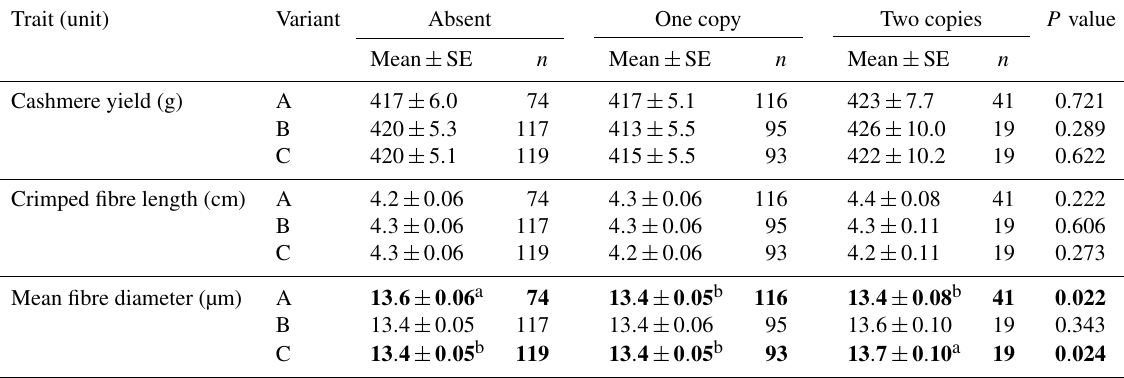
∗ Estimated marginal means and standard errors (SEs) of those means derived from general linear mixed-effects models. “Gender” and “sire” were included in the models as a fixed factor and a random factor, respectively. Means within rows that do not share a superscript letter ( a or b ) are significantly ( P< 0 . 05 ) different and are given in